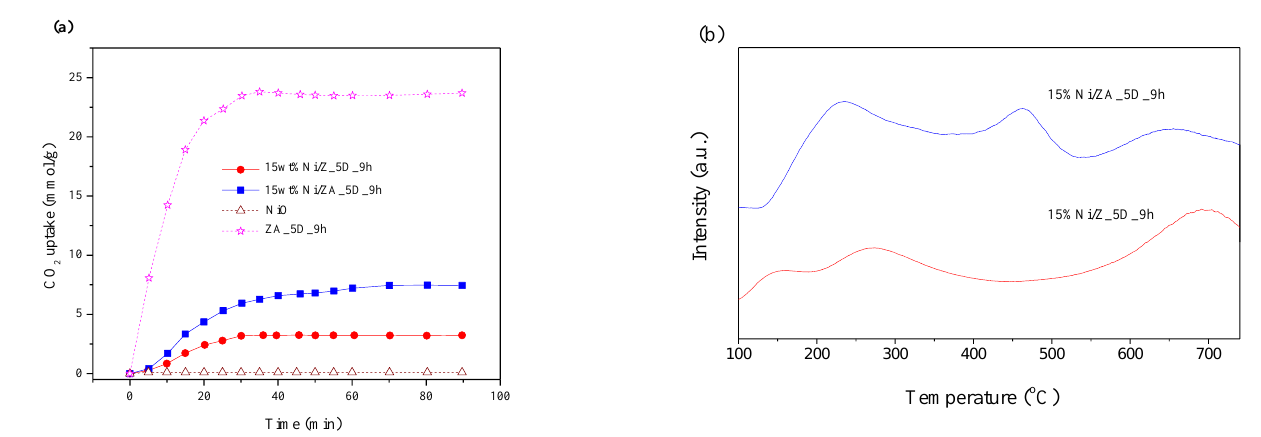
Figure 7. ( a ) CO 2 uptake and ( b ) CO 2 -TPD of 15wt%Ni/Z_5D_9h and 15wt%Ni/ZA_5D_9h.